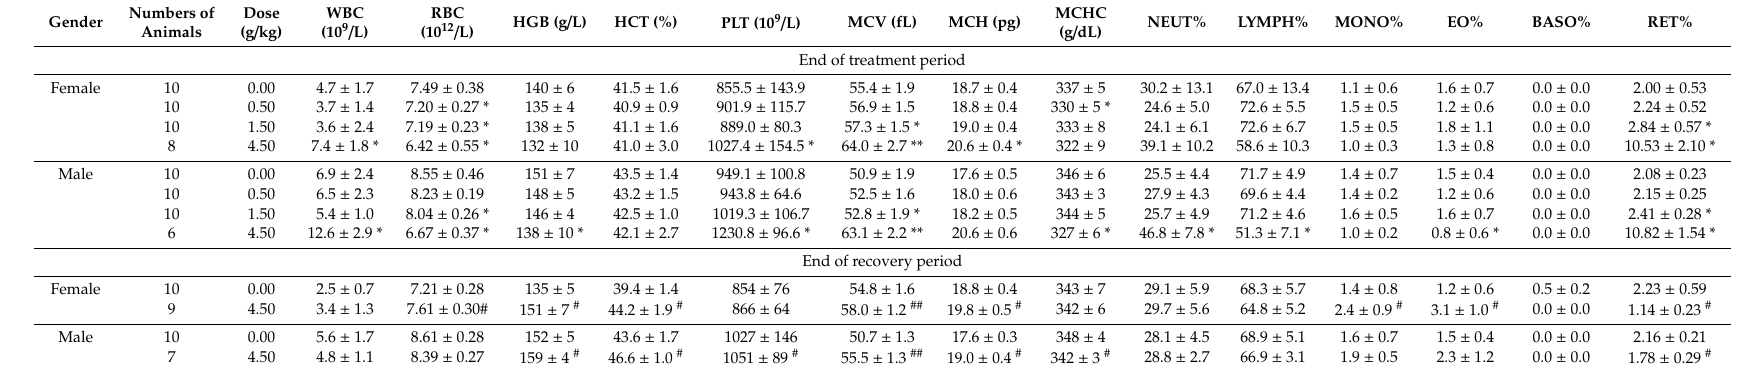
Table 1. Hematology parameters of S-D rats orally administrated with gardenia yellow for 90 days.